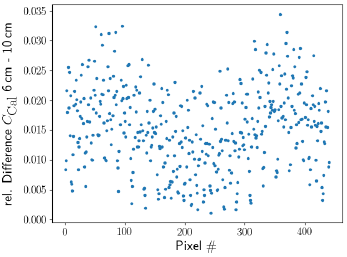
Figure 4. Difference of calibration constants of the FD camera between a scan grid of 6 cm and of 10 cm obtained from simulations.